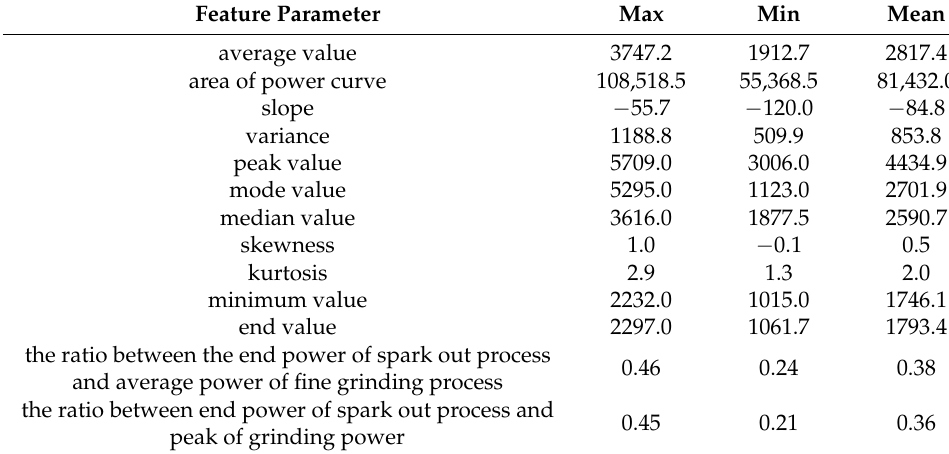
Table 2. The grinding power of spark out process and its derived variables.